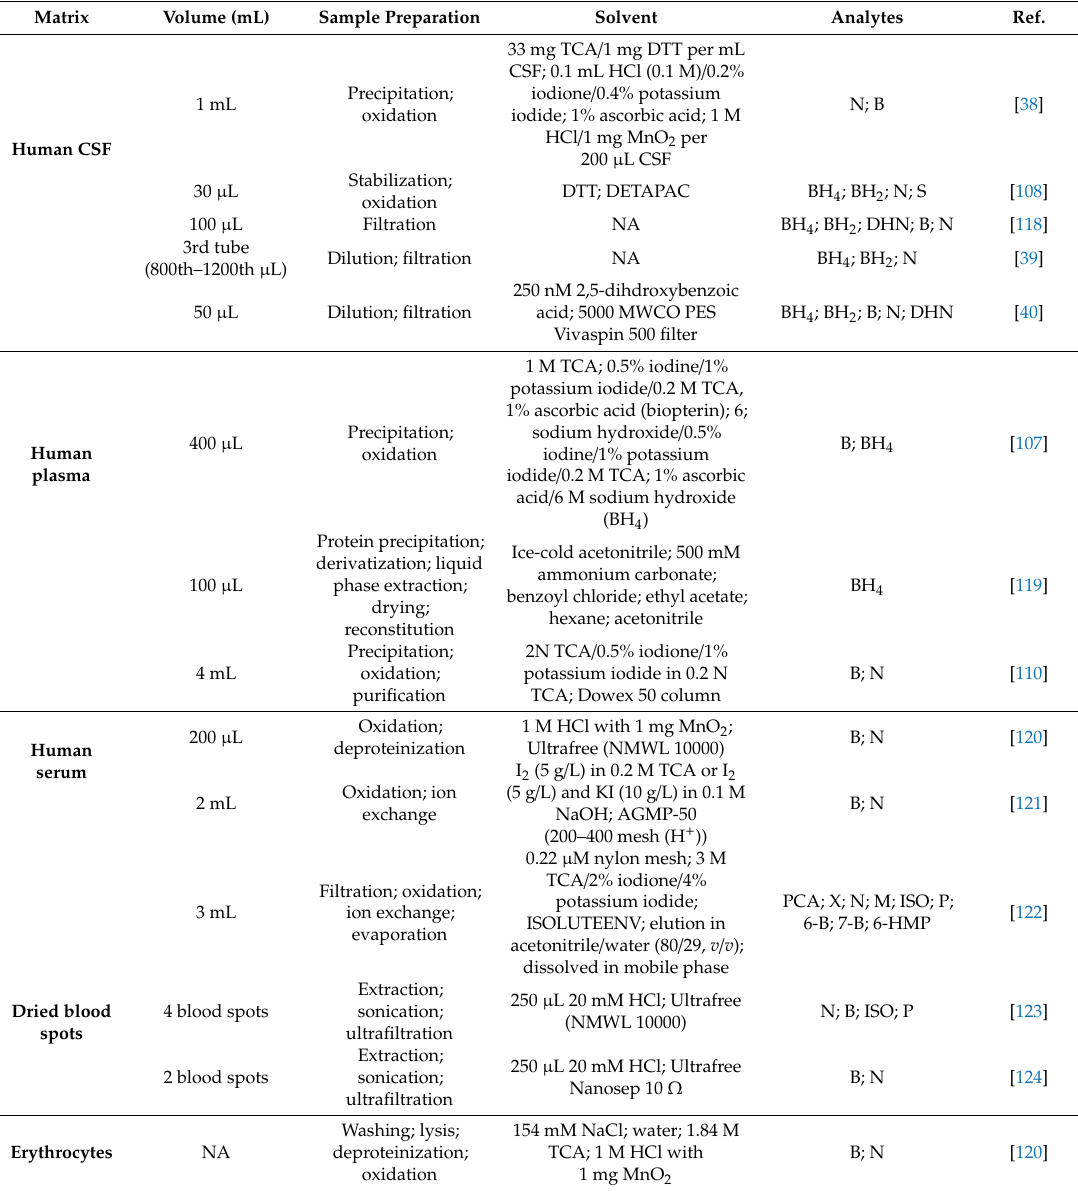
Table 4. Sample pre-treatment for the measurement of pterins in di ff erent human fluids. Matrix Sample Preparation Solvent Analytes